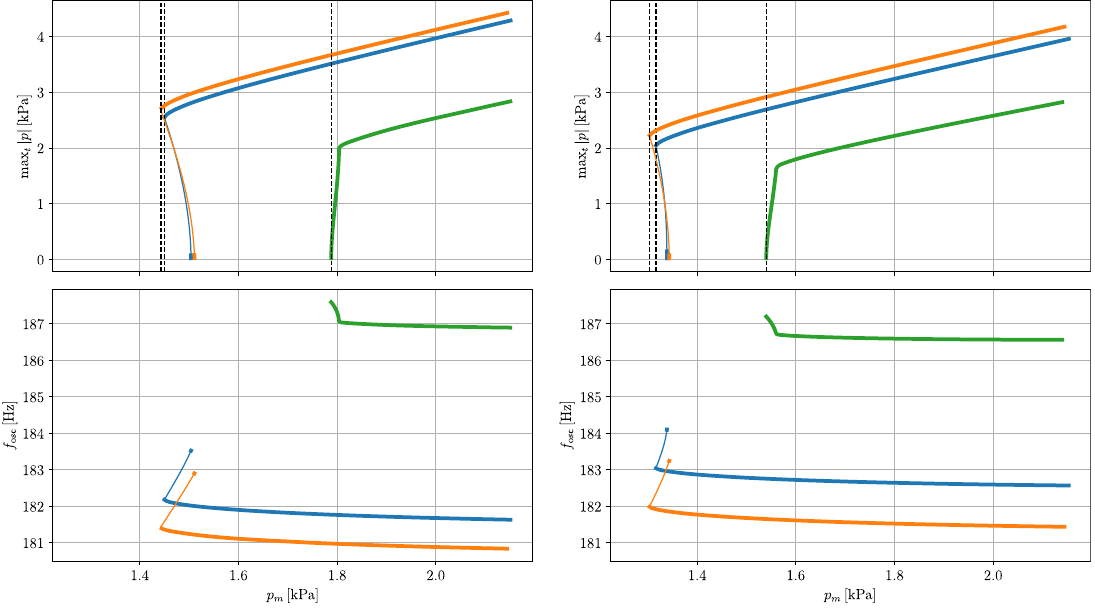
Figure 6. Top and bottom plots represent respectively the maximum amplitude of the periodic oscillation branches and their oscillation frequency versus the blowing pressure. Left: case H = h 0 ; right: case H / 1 = f l . Blue curves: case f l ¼ f opt ; eq l ; = 165.84 Hz 3 (left) or 167.75 Hz (right); orange curves: case f l ¼ f opt ; per l ; = 164.00 Hz (left) or 165.17 Hz (right); green curves: case f l = 175.09 Hz, 3 which corresponds to an arbitrary f l value at which the Hopf bifurcations are direct. The line thickness indicates whether the branch portion is stable (thick line) or unstable (thin line). The vertical dashed lines locate the value of the minimal threshold mouth pressure of each